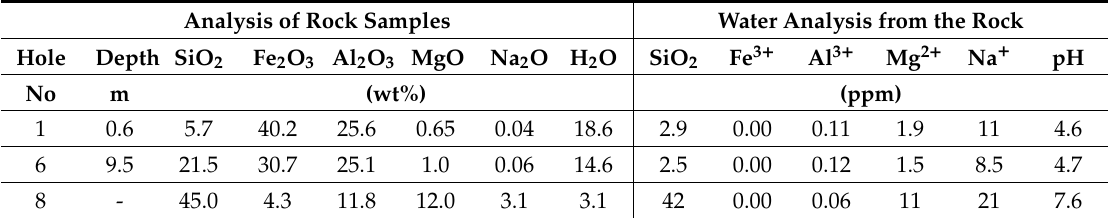
Table 1. Trace Analysis of Kauai Basalt Taken from Boreholes at Various Depths. Analysis of Rock Samples Water Analysis from the